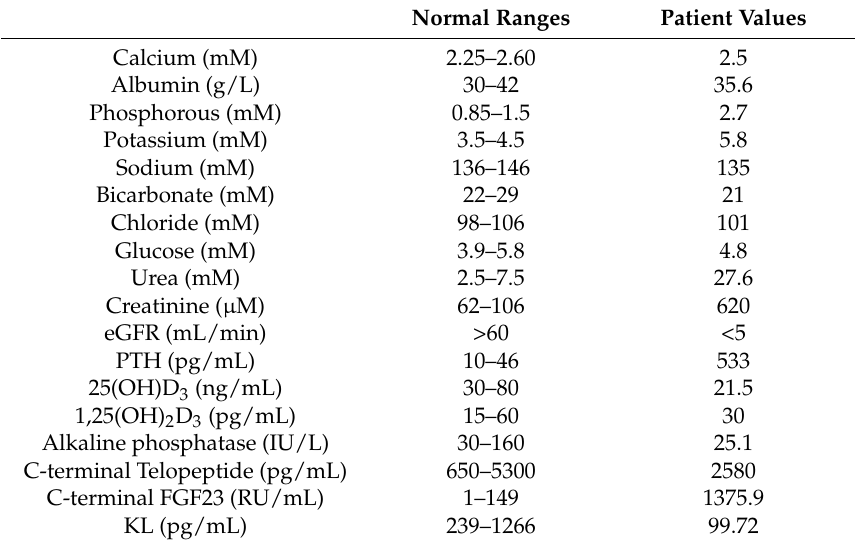
Table 1. Laboratory data of the patient with heterozygous deletion variant in the KL gene. Normal Ranges Patient